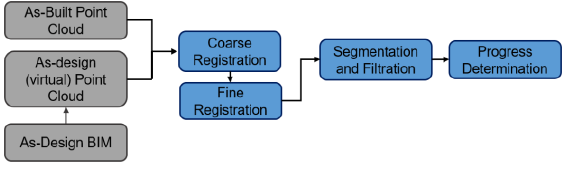
Figure 2. The developed